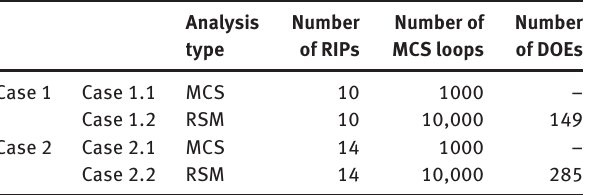
Table 2 Summary of the probabilistic case